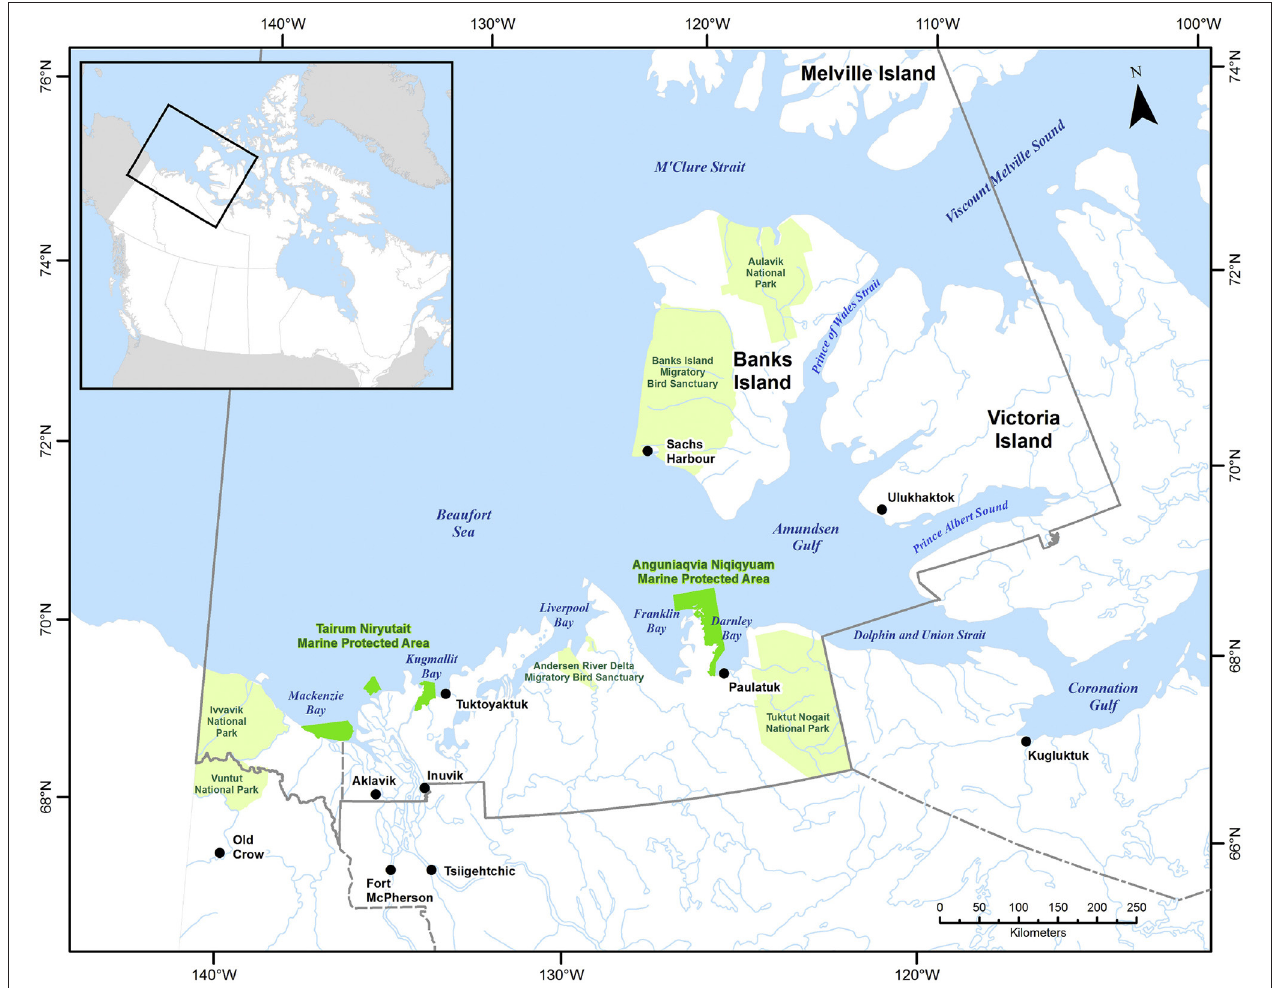
FIGURE 1 | Geographic representation of the Western Canadian Arctic and the Inuvialuit Settlement Region (ISR). The Tarium Niryutait Marine Protected Area (TN MPA, made up of three separate parcels in the Mackenzie Estuary) and the Anguniaqvia Niqiqyuam Marine Protected Area (AN MPA, located in Darnley Bay are indicated in dark green, national parks and park reserves are shown in light green. The ISR boundary is shown in solid gray. Reproduced from Loseto et al. (2018) with permission from